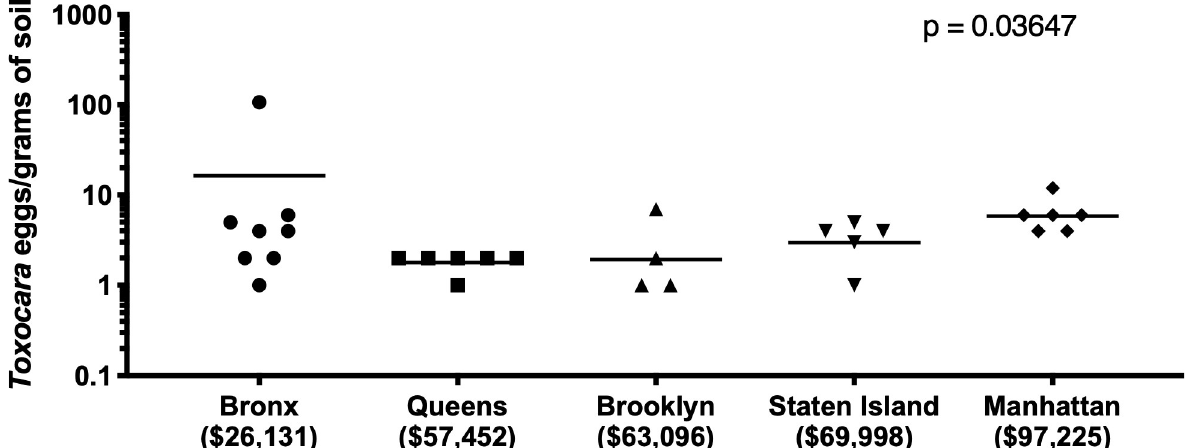
Fig 5. Toxocara eggs/park by borough. Kruskal-Wallis P = 0.0365. Eggs were not equally distributed in the parks by borough. The Bronx � has the highest egg burden compared to the other